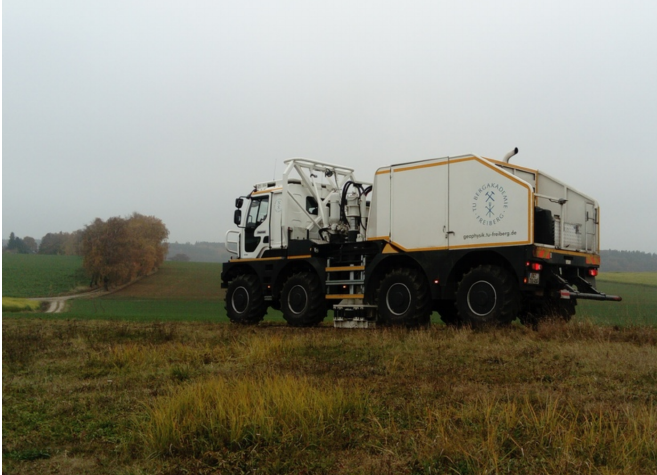
Figure 3. For the active part of the experiment a Vibroseis truck operated by the TU Bergakademie Freiberg (type: Thomas, VIB 3246) performed 480